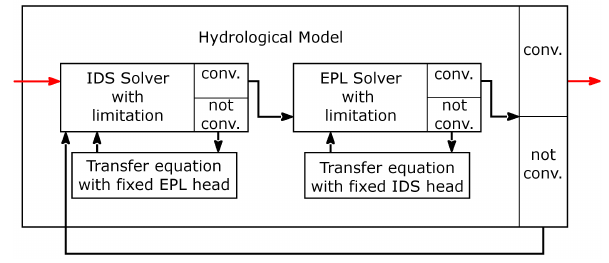
Fig. 3. Schematic description of the iteration scheme of the hydro- logical model. The outer box represents the entire model and each of the inside boxes is a component of the system which is solved with information from the other components. The convergence or not of each system is indicated with its iterative loop. The red ar- rows represent the start and end of a hydrological time